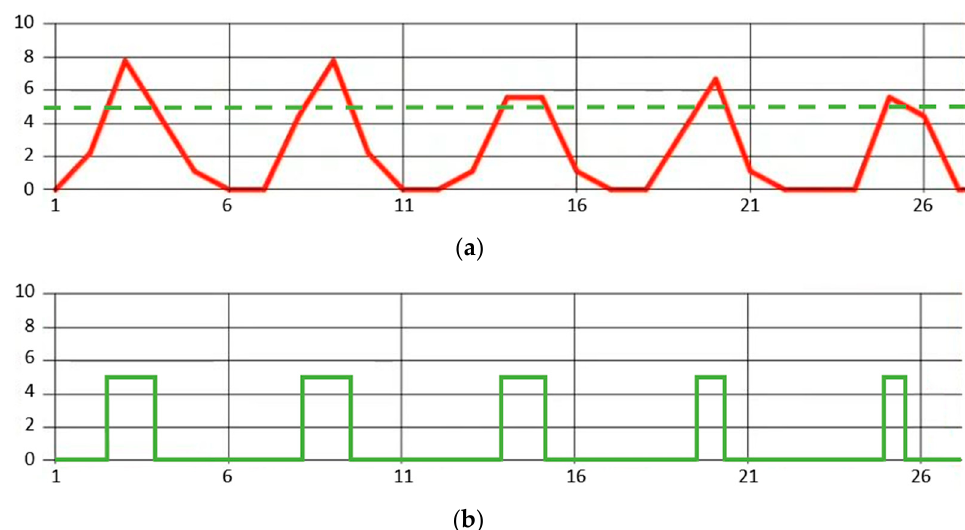
Figure 23. The waveform analysis of the circulation step: ( a ) original data; ( b ) processed